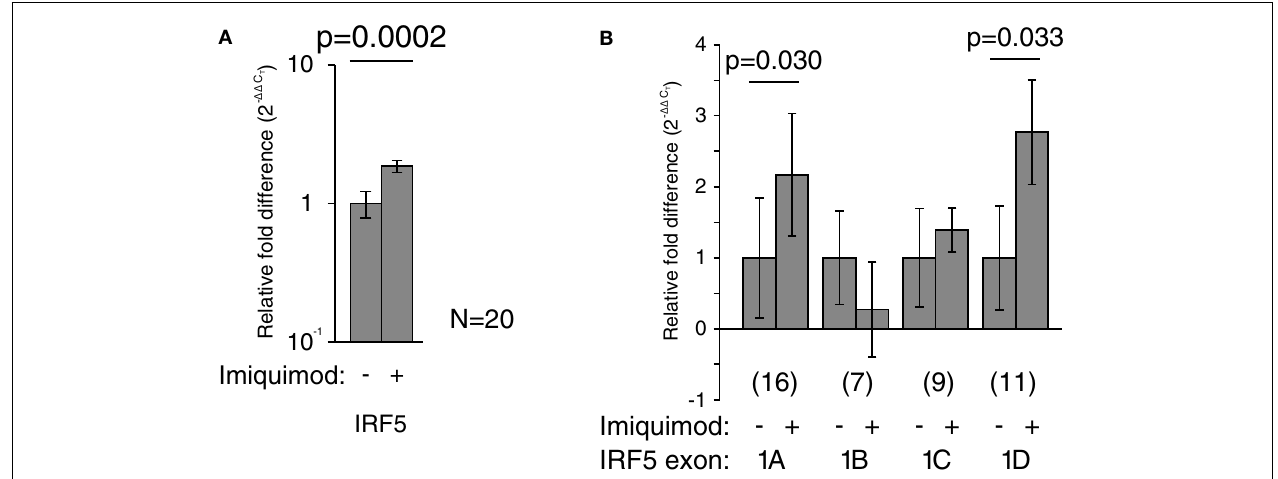
values were normalized to the β -GUS housekeeping gene.The numbers in parentheses indicate the sample size. Analysis of variance was performed including each first exon and stimulation state as groups.This analysis revealed statistically significant variation ( p < 0.0001). Statistical significance between individual groups was determined by paired t -test. IRF, interferon regulatory